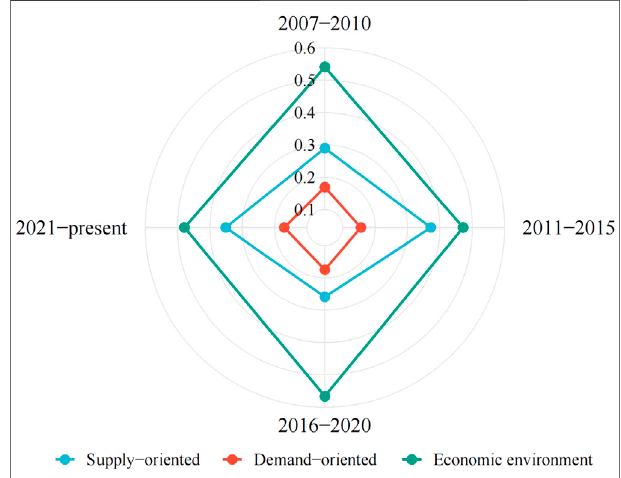
FIGURE 3 | The proportion of different policy tools at each